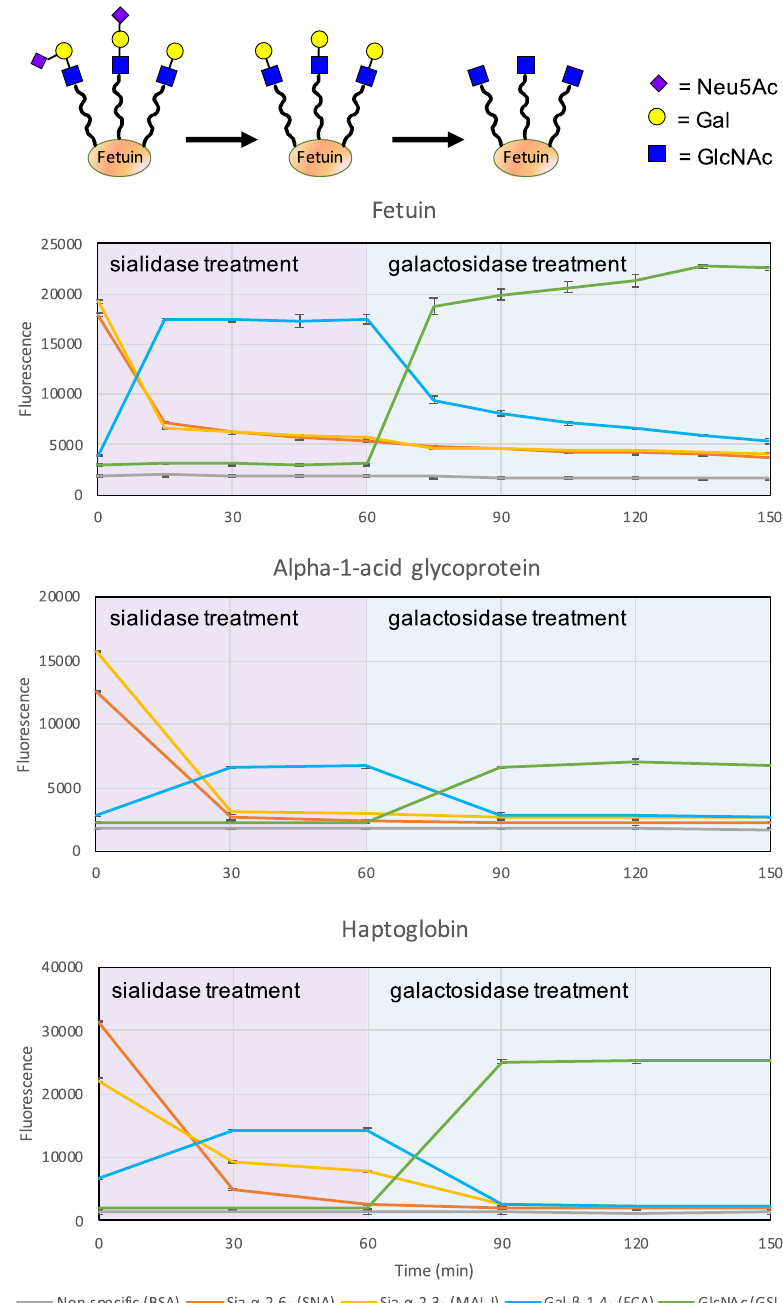
Figure 5. Time courses for the treatment of glycoproteins (upper panel: fetuin, middle: alpha-1-acid glycoprotein, lower: haptoglobin) with sialidase (T = 0 min) and subsequently with galactosidase (T = 60 min). Error bars are standard deviations from